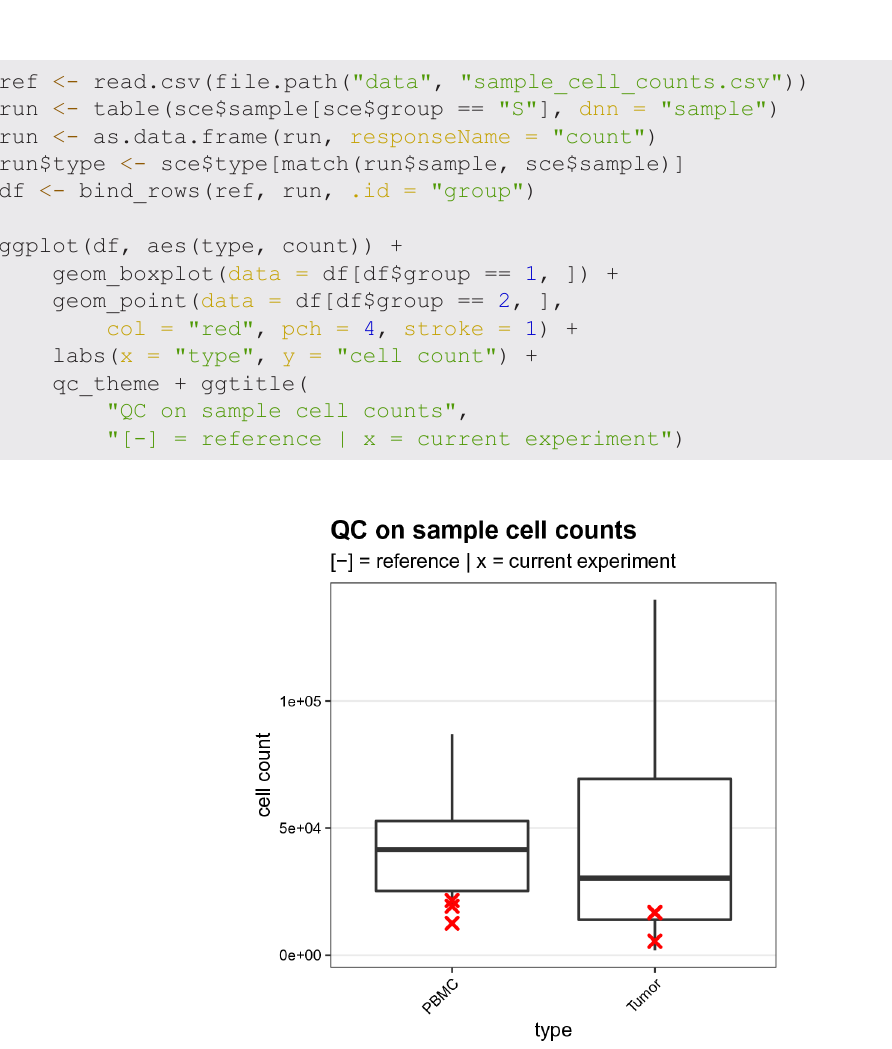
Figure 15. Sample cell count quality control. Boxplot comparing the sample cell counts obtained for the current experiment (red crosses) to those from 7 previously acquired experiments.